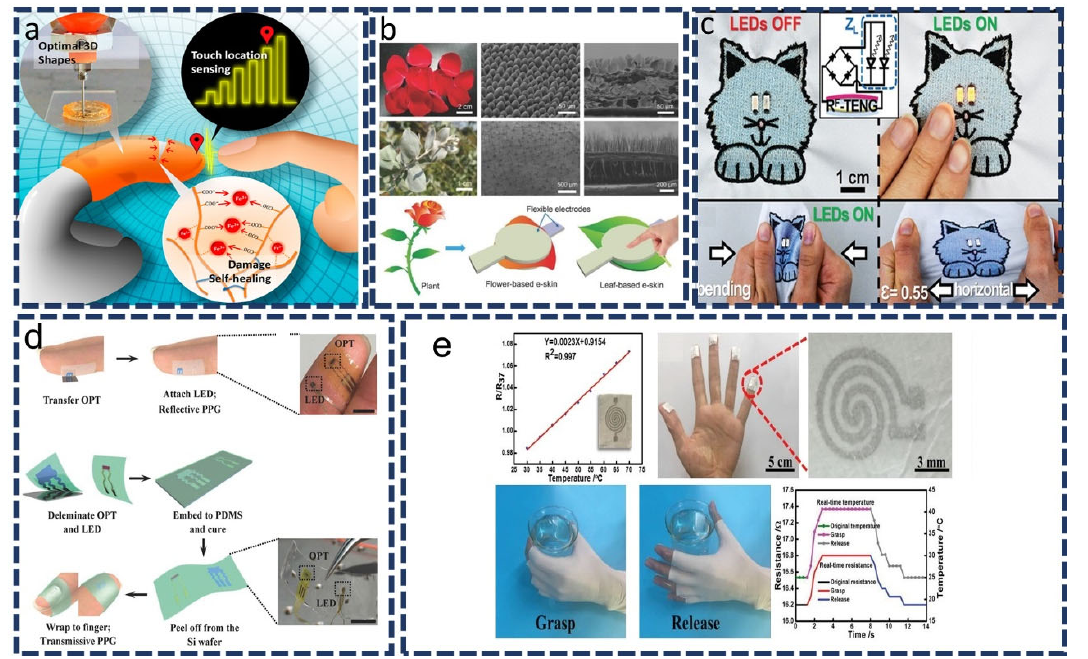
Figure 6. ( a ) 3D ‐ printed fingertip ‐ shaped artificial skin device that senses precise touch location and automatically heals mechanical damage. Reproduced with permission from ACS (2020) [94]. ( b ) An illustration of an e ‐ skin, which consists of two electrodes with a layer of dielectric material (flower and leaf) between them. Reproduced with permission from Wiley ‐ VCH (2018) [95]. ( c ) Triboelectric nanogenerators (RF ‐ TENGs) fabricated from e ‐ textiles shaped similar to cats that power two LEDs embroidered on the body (when touched). Reproduced with permission from Wiley ‐ VCH (2019) [103]. ( d ) It is comprised of an OPT and an LED that are laminated directly onto the finger to form a PPG sensor for the purposes of cardiovascular monitoring. Reproduced with permission from Wiley ‐ VCH (2017) [106]. ( e ) A finger is attached to the nanomesh film devices for tissue temperature sensing. Reproduced with permission from Wiley ‐ VCH (2019) [107].